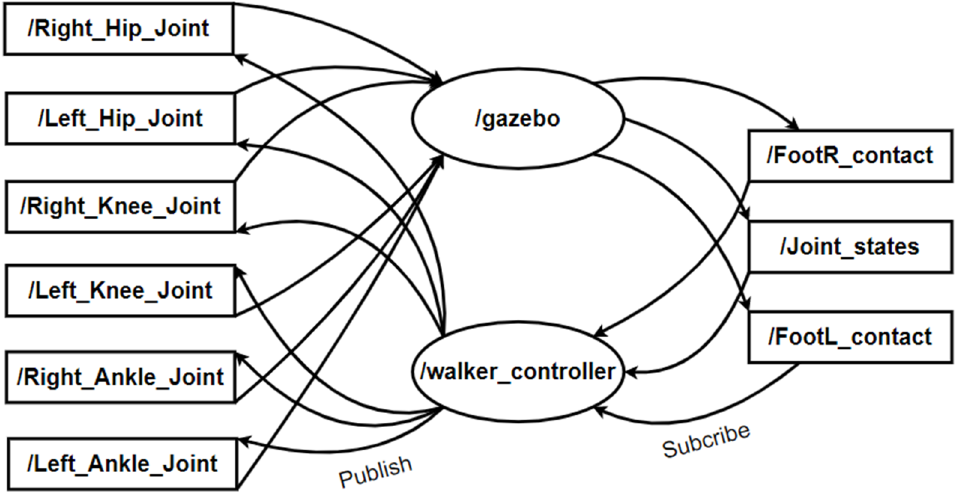
Figure 5. Communication between nodes and topics in ROS. Ovals represent nodes and rectangles represent topics.